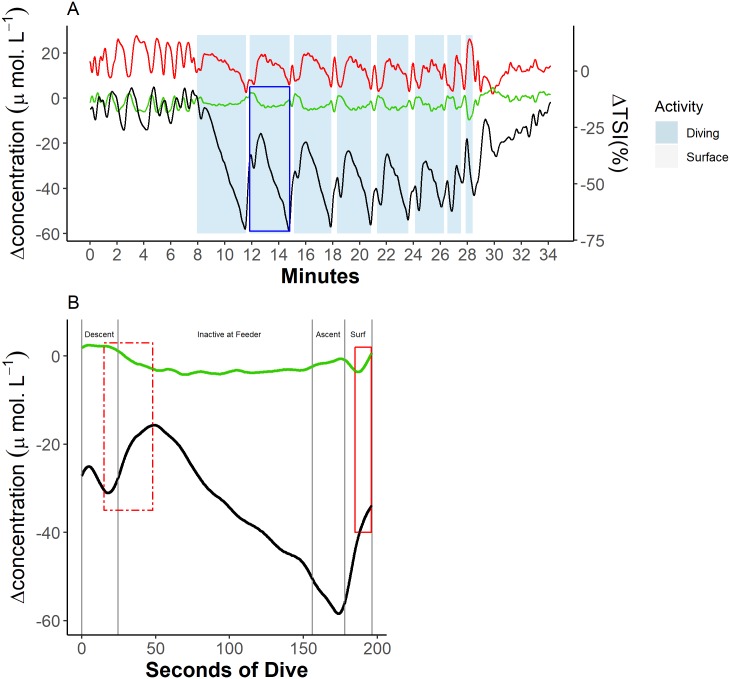
Example trace of cerebral blood volume and haemoglobin oxygen dynamics during a sequence of dives from a single animal (Ulf).(A) Blood volume [tHb], haemoglobin oxygenation [Hbdiff], and ΔTSI% dynamics across all the dives in a trial, where the green line = blood volume, black line = haemoglobin oxygenation, and red line = TSI. (B) [tHb] and [Hbdiff] dynamics across a single dive marked in blue box in (A). Vertical grey lines indicate changes of dive phase, where ‘Descent’ = transit from the surface to the feeding station (feeder), ‘Ascent’ = transit from the feeding station back to the surface, and ‘Surf’ = at the surface. The box in a dashed red line indicates a period of secondary reoxygenation. The box in a solid red line indicates a mid-surface interval increase in blood volume. All concentrations are expressed as a relative change from a baseline (0 μmol.L−1) taken as the onset of the first dive in a recording session. Data can be found here: https://doi.org/10.5061/dryad.k67cg66. [Hbdiff], difference in the concentration of oxy- and deoxyhaemoglobin; [tHb], concentration of total haemoglobin; TSI, tissue saturation index.